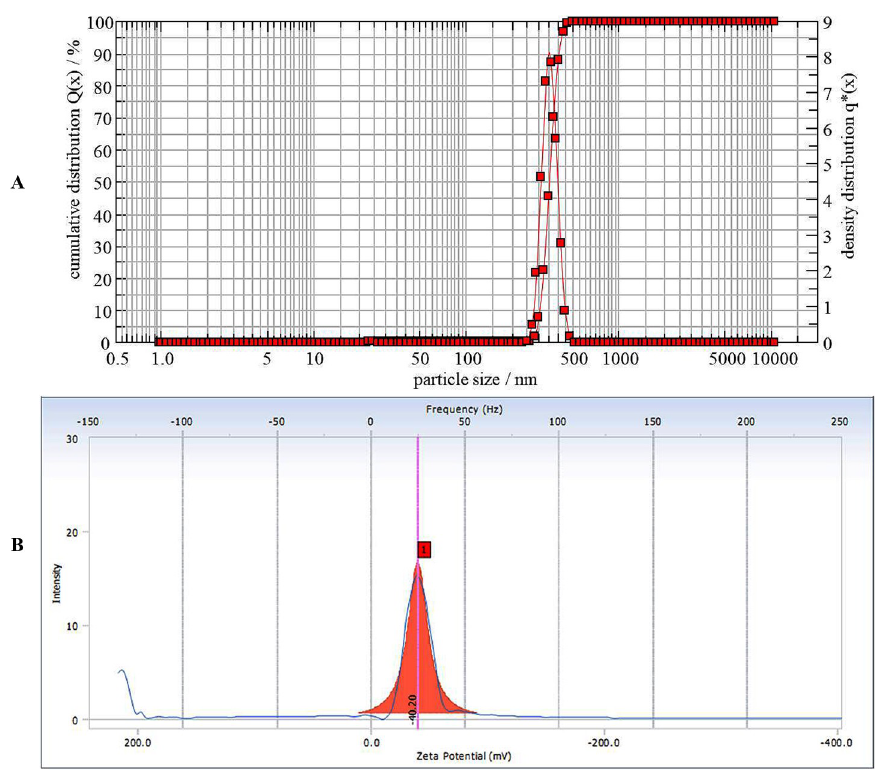
Fig 5. Particle size (A) and Zeta Potential (B) analysis of HTN.